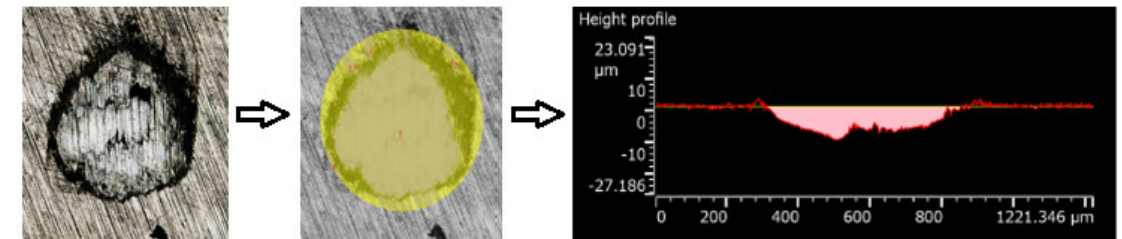
Figure 5. Stages of volumetric wear measuring after fretting wear tests.